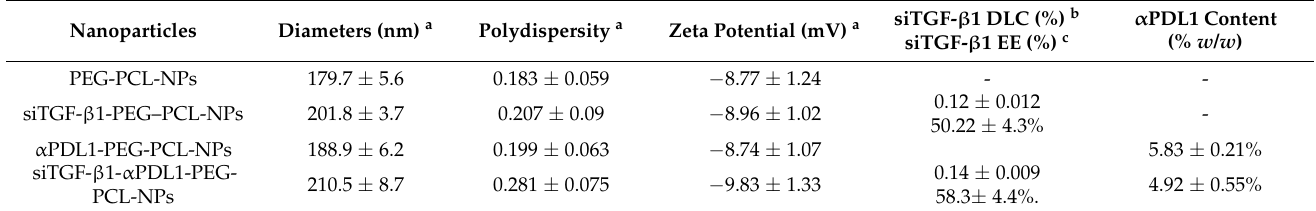
Table 2. Mean particle size and drug loading efficiency in the four types of